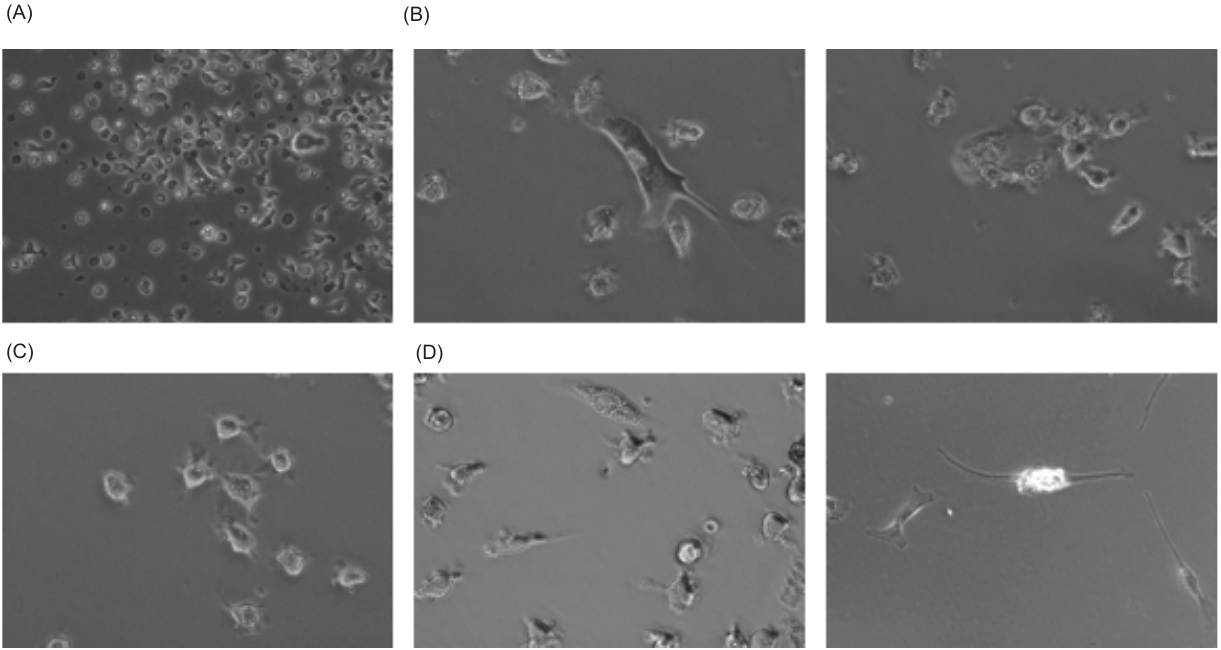
Figure 2: Tumor-infiltrating immune cells interact with cancer-associated fibroblast-like cells. Live imaging (before fixation). Representative bright-field images of tumor stroma from the same patient are shown (images